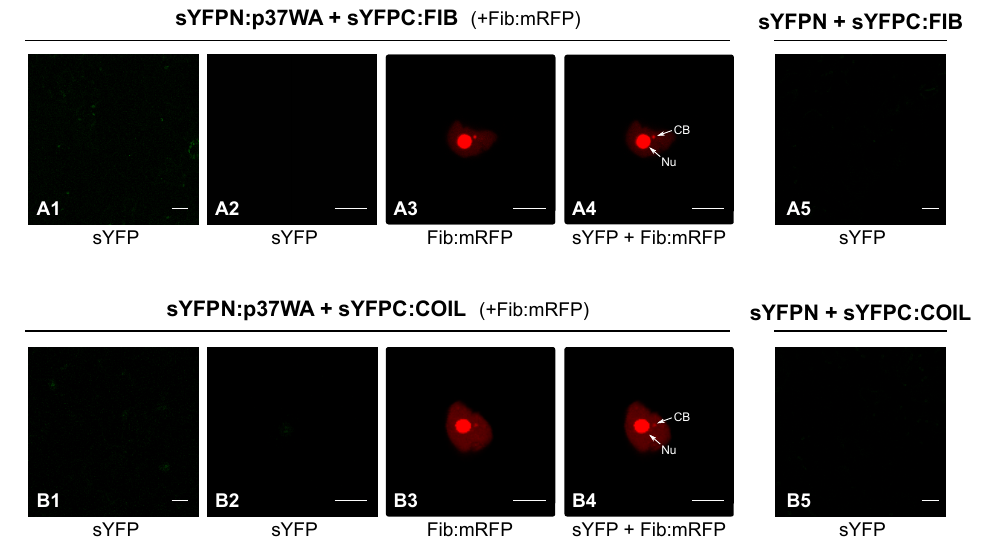
Figure 3. In vivo analysis of the potential interaction of p37WA mutant with fibrillarin and coilin. Protein p37WA, fibrillarin (FIB), and Coilin (COIL) were tagged at their N-terminus with YFP halves (sYFPN and sYFPC) and transiently co-expressed in N. benthamiana leaves to study the protein–protein interactions through a BiFC assay. FIB-mRFP was also co-expressed in these assays as a nucleolar/CB marker. Confocal laser scanning microscopy was used for the observation of fluorescence at 3 dpi. The micrographs ( A1 , B1 ) show a general view of YFP-derived fluorescence in epidermal cells expressing sYFPN:FIB and sYFPN:COIL, respectively, in combination with sYFPC-tagged p37WA molecules; the micrographs ( A2 , B2 ) show a close view of YFP-derived fluorescence from the same protein-tagged combinations; the micrographs ( A3 , B3 ) correspond to the same close views but record the RFP fluorescence derived from FIB:mRFP; the micrographs ( A4 , B4 ) show overlays of ( A2,A3,B2,B3 ), respectively. Equivalent images were obtained with reverse combinations (sYFPC:FIB or sYFPC:COIL co-expressed with sYFPN-tagged p37WA molecule) (data not shown). Negative control combinations (sYFPN-sYFPC:FIB; sYFPN-sYFPC:COIL) are displayed in micrographs ( A5 , B5 ), respectively. Nu: nucleolus. CB: Cajal body. The inset scale bar corresponds to 20 µm in the first column panels and to 10 µm in all remaining panels.